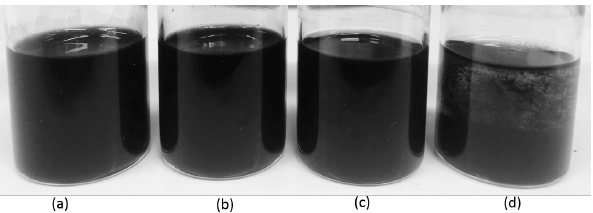
Figure 6. fMWCNT/solvent dispersion after 1 day: ( a ) Water; ( b ) Ethanol; ( c ) 2-propanol; ( d ) Toluene.